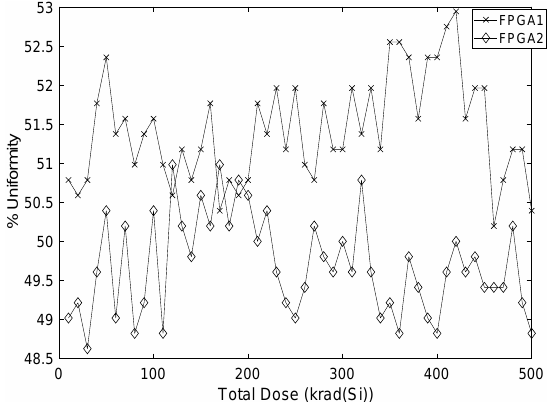
Figure 9. Uniformity vs.